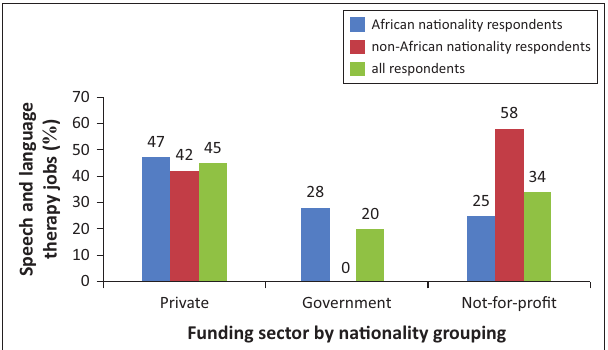
FIGURE 1: Funding sector of speech and language therapy jobs, by nationality grouping.